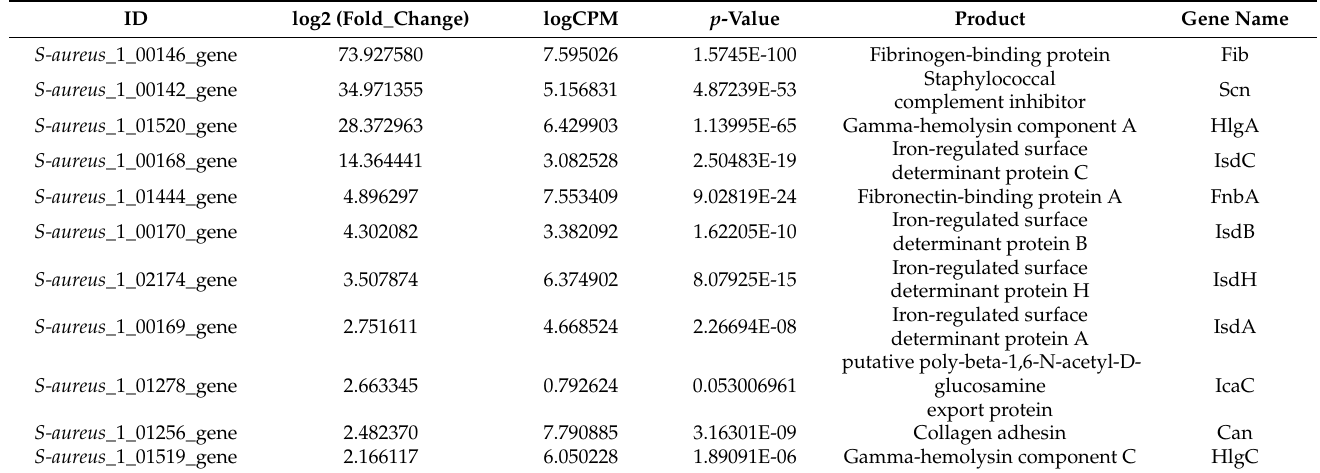
Table 12. Differentially expressed genes in biofilms compared with planktonic biofilms.